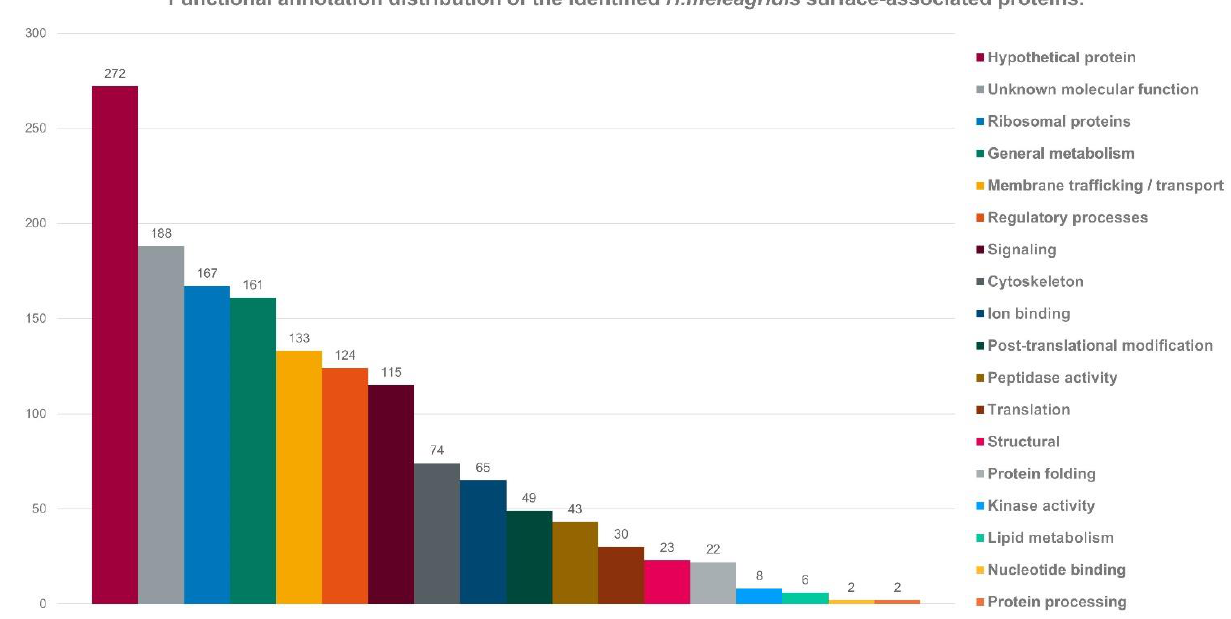
Figure 4. Distribution of functional annotations of the identified H. meleagridis surface-associated proteins. Functional groups were classified by BLAST homology analysis.